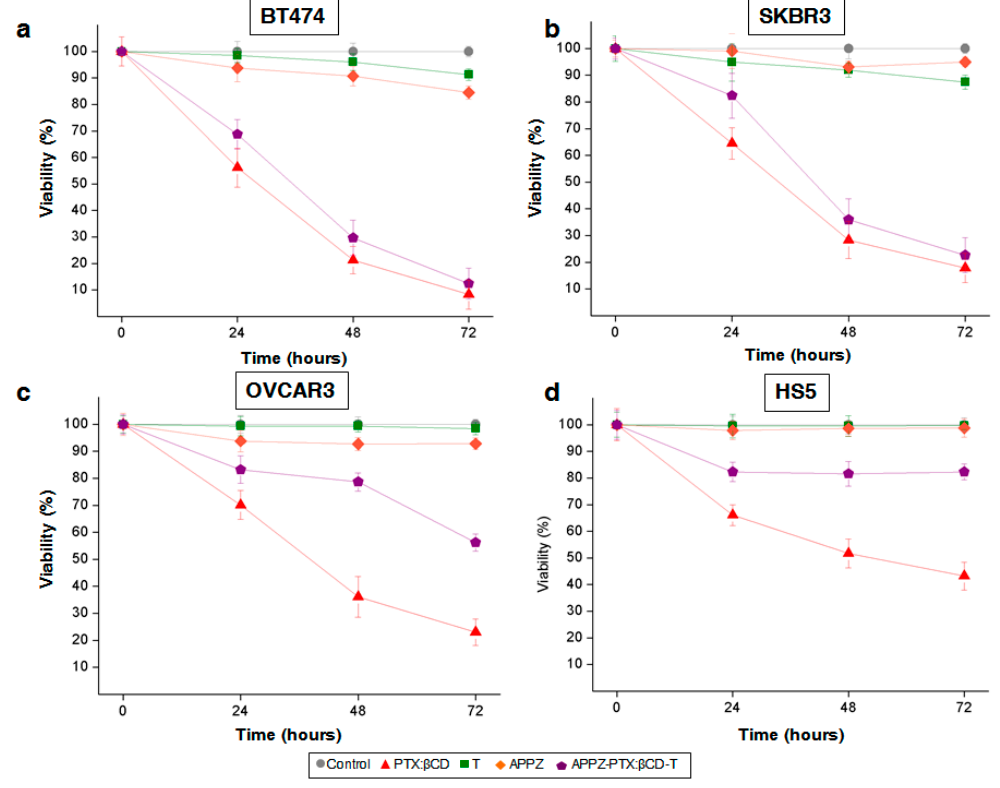
Figure 5. Conjugated APPZ antiproliferation effect in ( a ) BT474; ( b ) SKBR3; ( c ) OVCAR; and ( d ) HS5 cells. Shown results are the mean ± SD of four replicas for each different treatment.